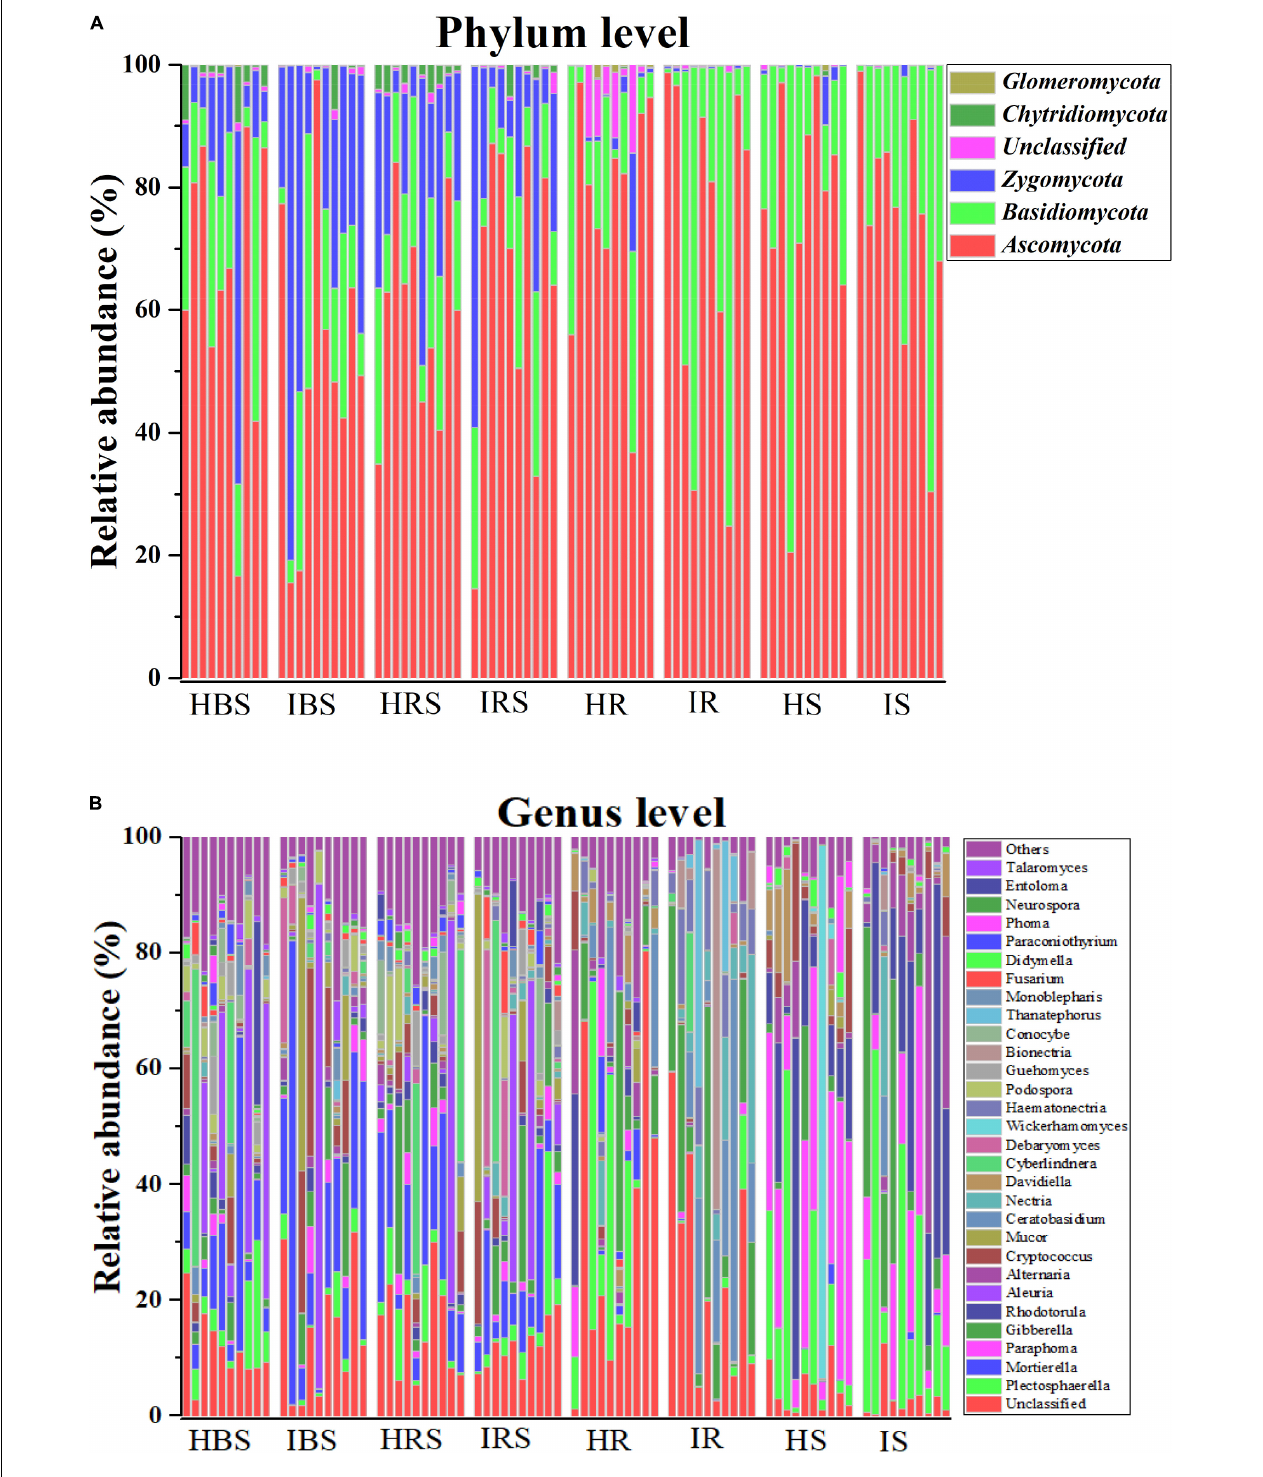
FIGURE 2 | Comparison of the community compositions of soil and plant endophytic fungi from healthy and infected samples. (A) Comparison of the community compositions of the healthy and infected bulk soil, rhizosphere soil, and root and stem endophytic compartments with relative abundance > 1% OTUs at the phylum level. (B) Comparison of the community compositions of the healthy and infected bulk soil, rhizosphere soil, and root and stem endophytic compartments with relative abundance > 1% OTUs at the genus level.